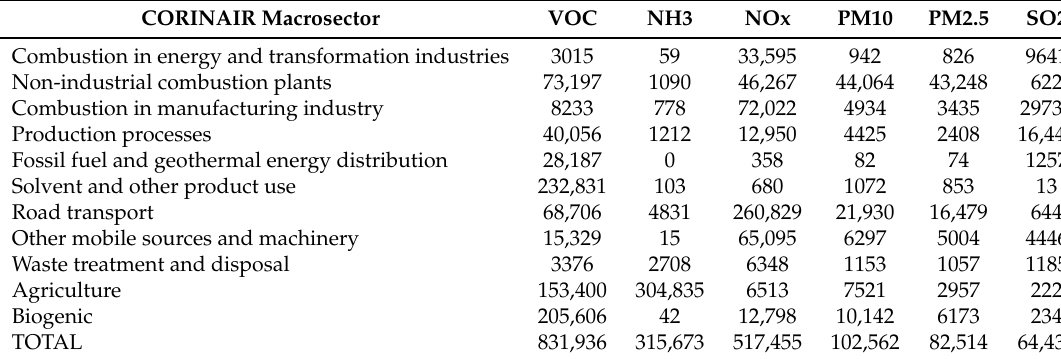
Table 1. Total annual emission [t/yr] over the CAMx domain for each pollutant and core inventory air emissions (CORINAIR) macrosectors for the year 2011.